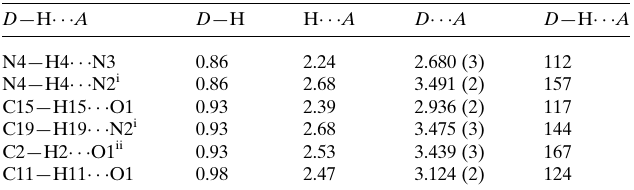
Table 1 Hydrogen-bond geometry (A˚ , (cid:3) ).